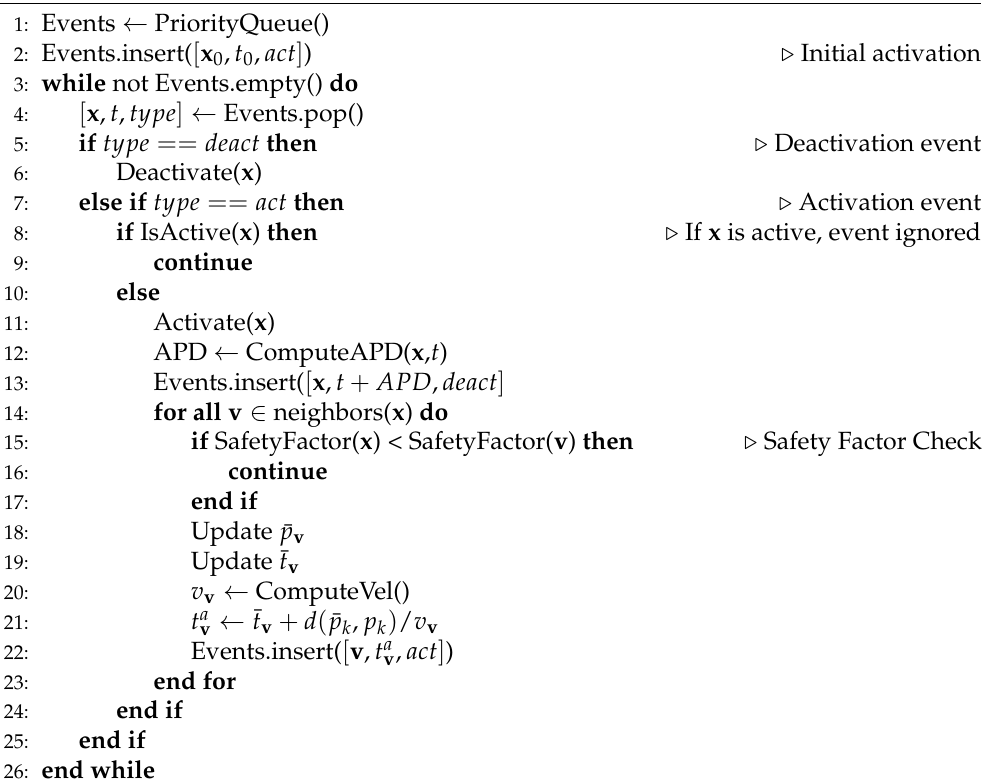
Algorithm 1 Activation propagation method. The reader can refer to the text for details on the